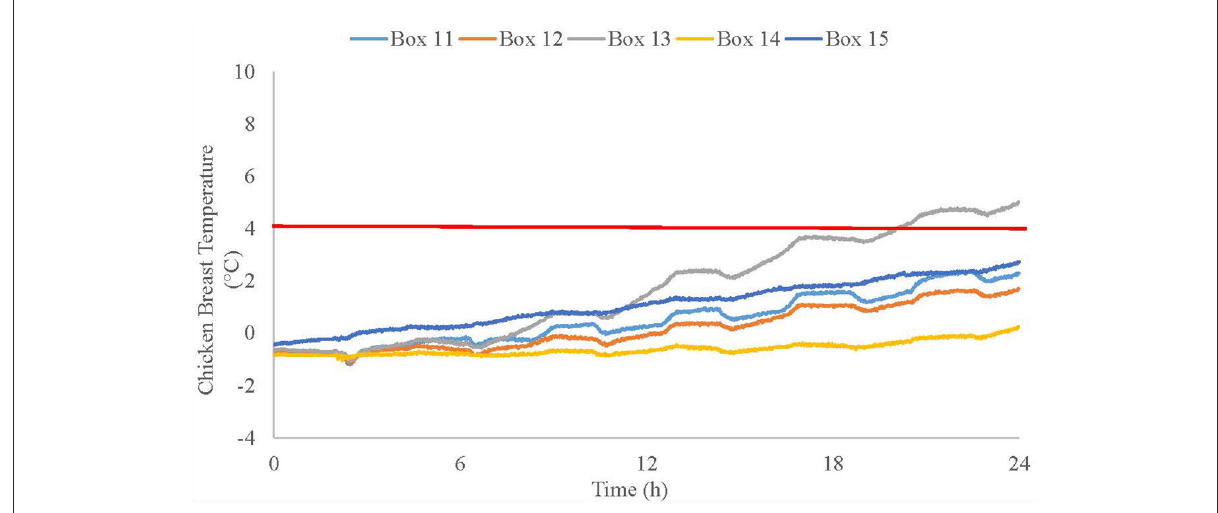
FIGURE4 Averaged temperature profiles (4 replications) of third layer from the top (layer 3) boxes of palletized chicken breasts while experiencing simulated LTL cyclic TA (2h at 4 ◦ C then 2h at 25 ◦ C).